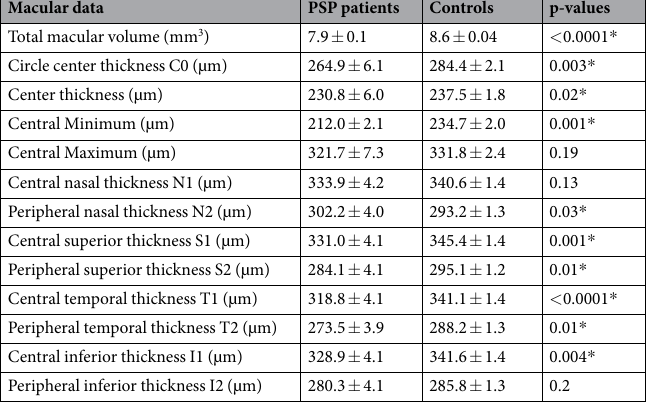
Table 3. OCT macular data of PSP patients and control probands (mean ± standard error, corrected for age and sex). P-values with significant differences are marked with *